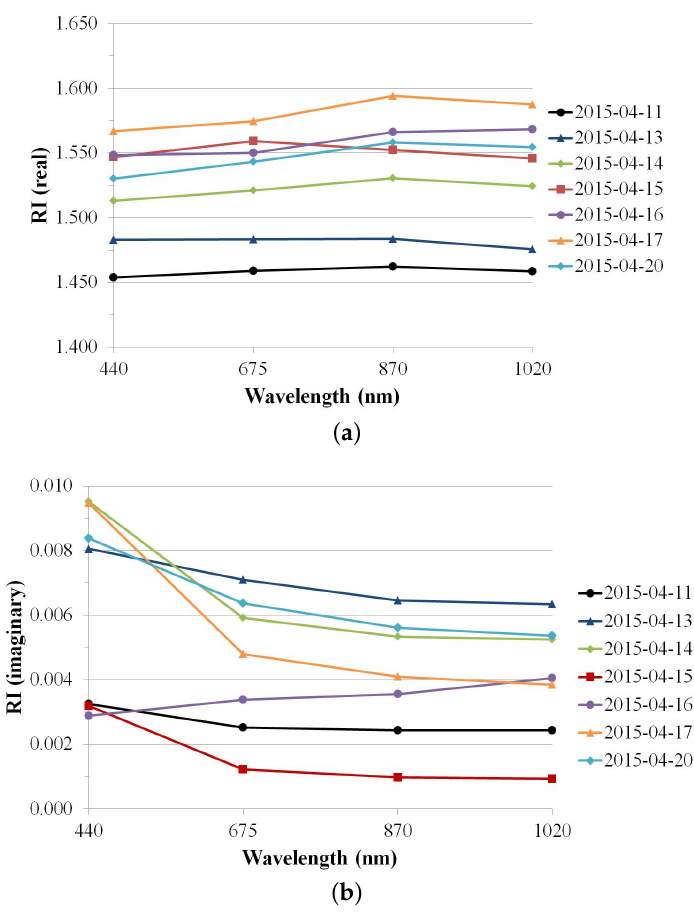
Figure 9. Variations of real ( a ) and imaginary ( b ) parts of refractive index during dusty and non-dusty